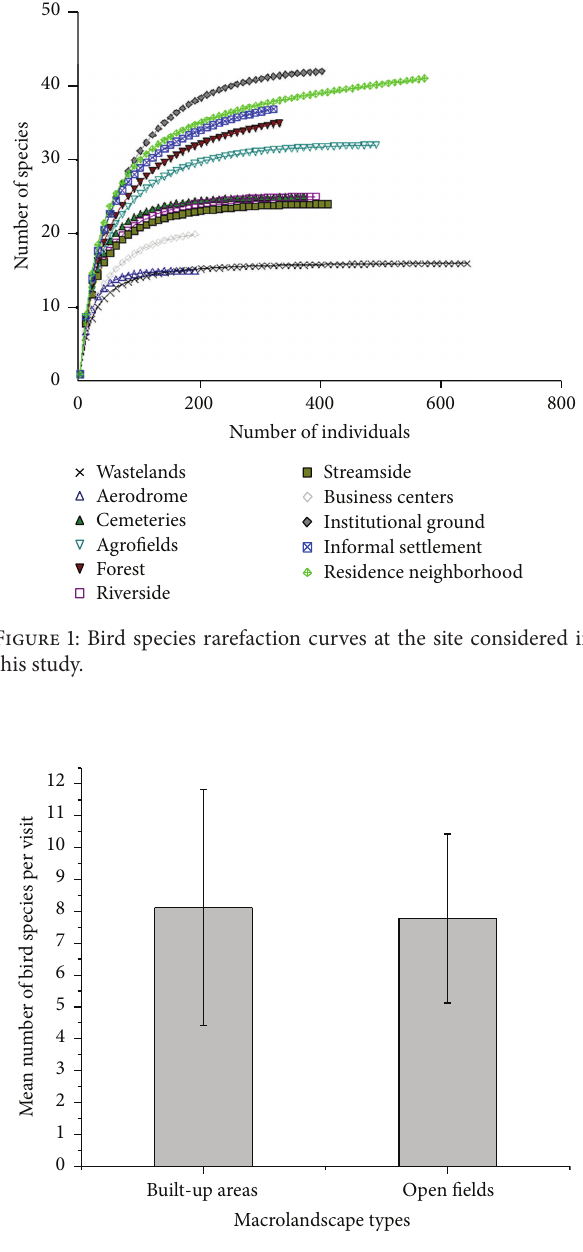
Figure 2: Mean number of species observed during plot visits in the two macrolandscape types.